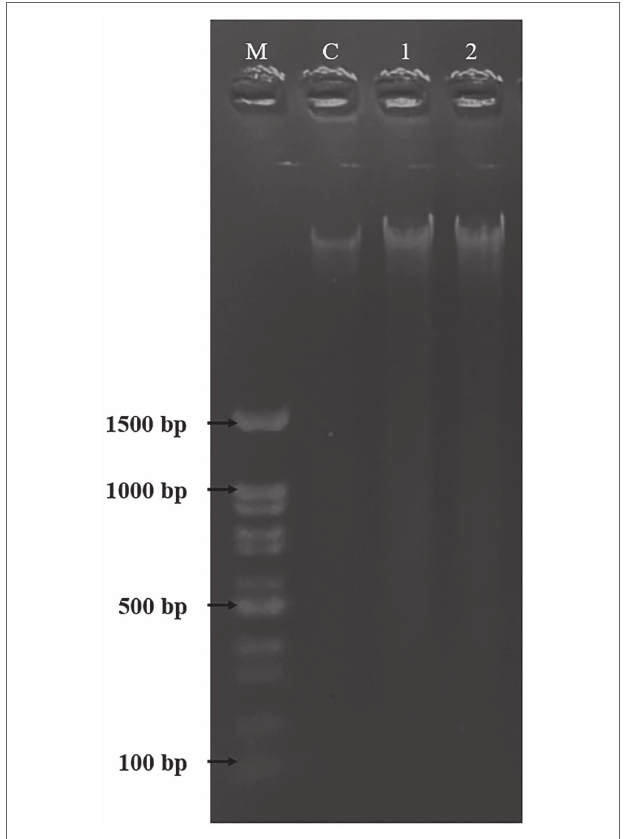
FIGURE 8 | The HepG2 cells treated with DMSO (0.5%) as comparative group and PAAEs (MW <3 kDa, IC 50 value at 0.54 mg/ml). DNA fragmentations were visualized under UV light with ethidium bromide staining. Lane M, DNA marker; Lane C, untreated cells; Lane 1, cells treated with 0.5% DMSO; and Lane 2, cells treated with